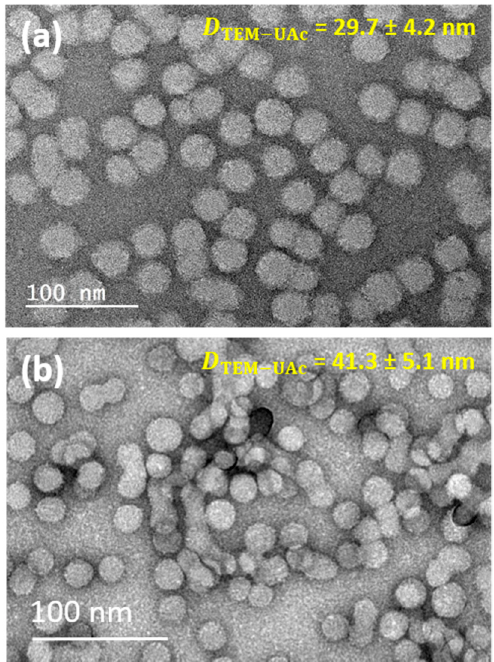
Figure 4. Negative stain electron microscopy of ( a ) PHEA 85 – b –PS 130 and ( b ) PHEA 23 – b –PS 130.